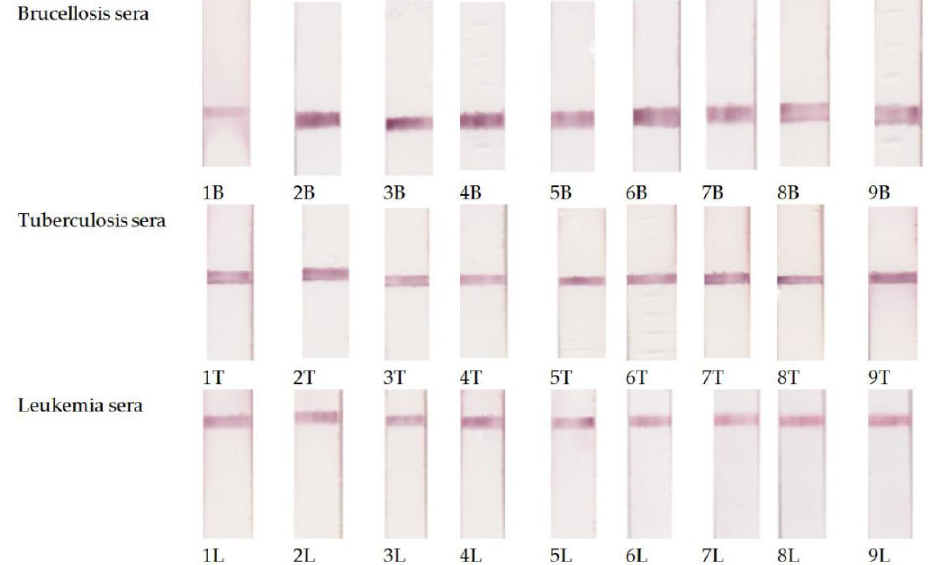
Figure 3. Examples of testing of the serum panel preliminarily characterized by ELISA using the developed multiplex immunochromatographic system.